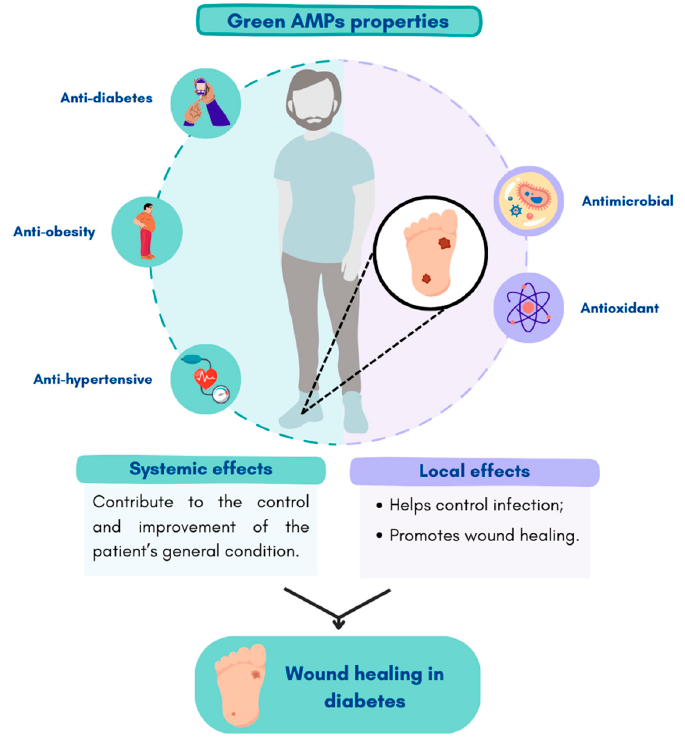
Figure 3. Effects of more environmentally friendly AMPs as potential therapeutic agents in chronic DFUs. Figure created in Canva.com (accessed on 21 February 2023).